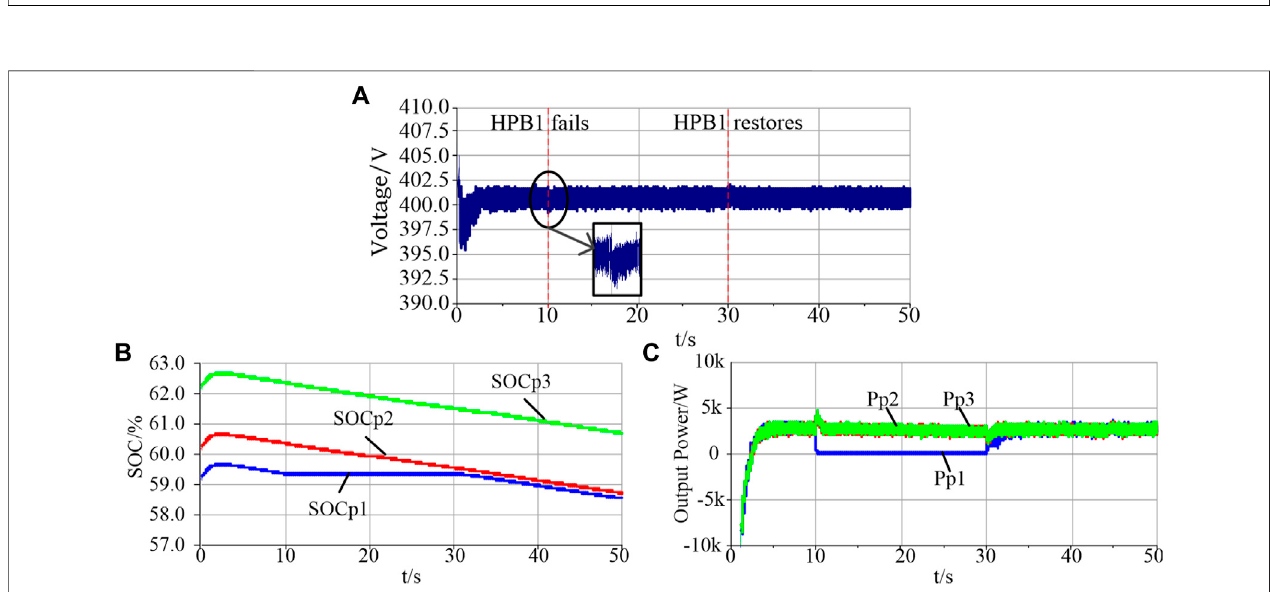
FIGURE 13 | Simulation results when No. 1 High-Power Battery fault: (A) Bus voltage; (B) High-Power Battery SOC; (C) Output power of High-Power Battery).